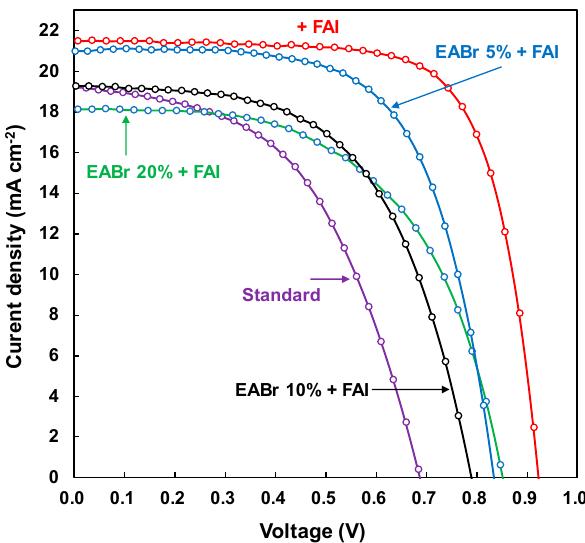
Figure 2. J–V characteristics collected in light condition for the fabricated solar cells. Figure 2. J – V characteristics collected in light condition for the fabricated solar